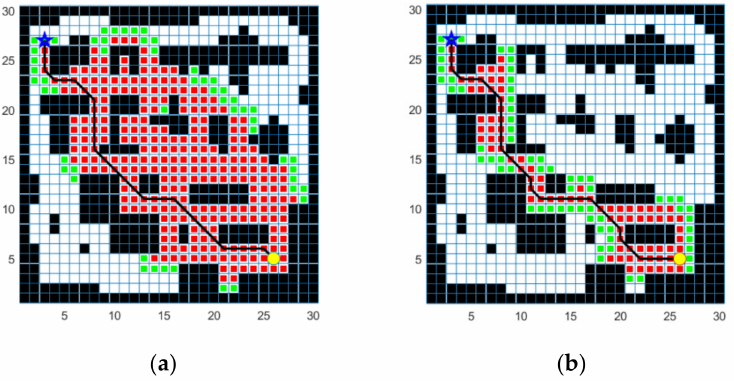
Figure 5. Two algorithmic tests: ( a ) Traditional A* algorithm; ( b ) adaptive weight strategy algorithm.